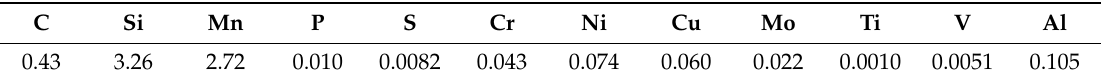
Table 1. Chemical composition of the investigated alloy